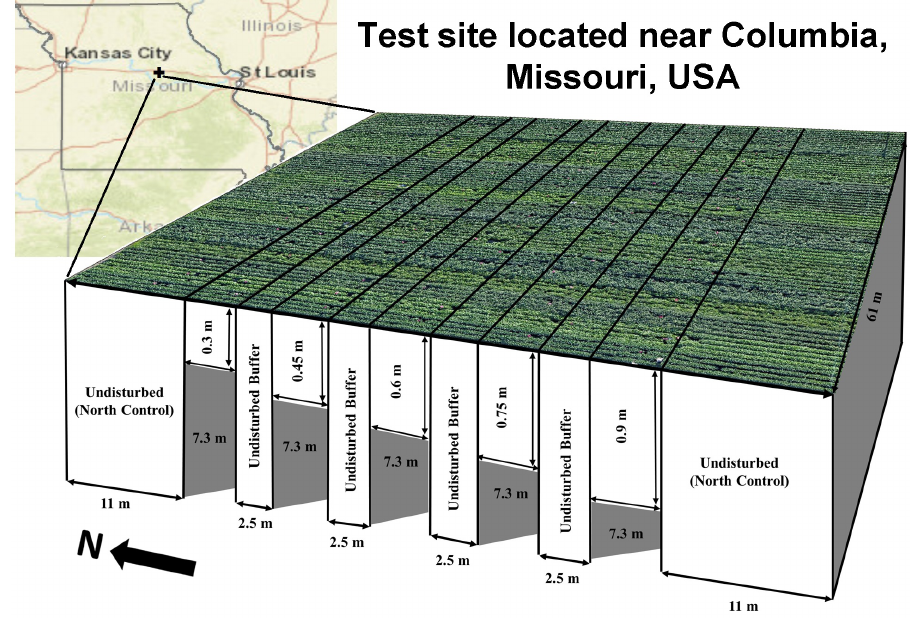
Figure 1. Test site location and UAV-based RGB imagery captured by Mavic Pro with restricting plant roots to different depth and undisturbed areas along with north-south orientation as well as between rooting depth treatments. The figure was modified after (Hoyos-Villegas et al. 2014, Sagan et al.